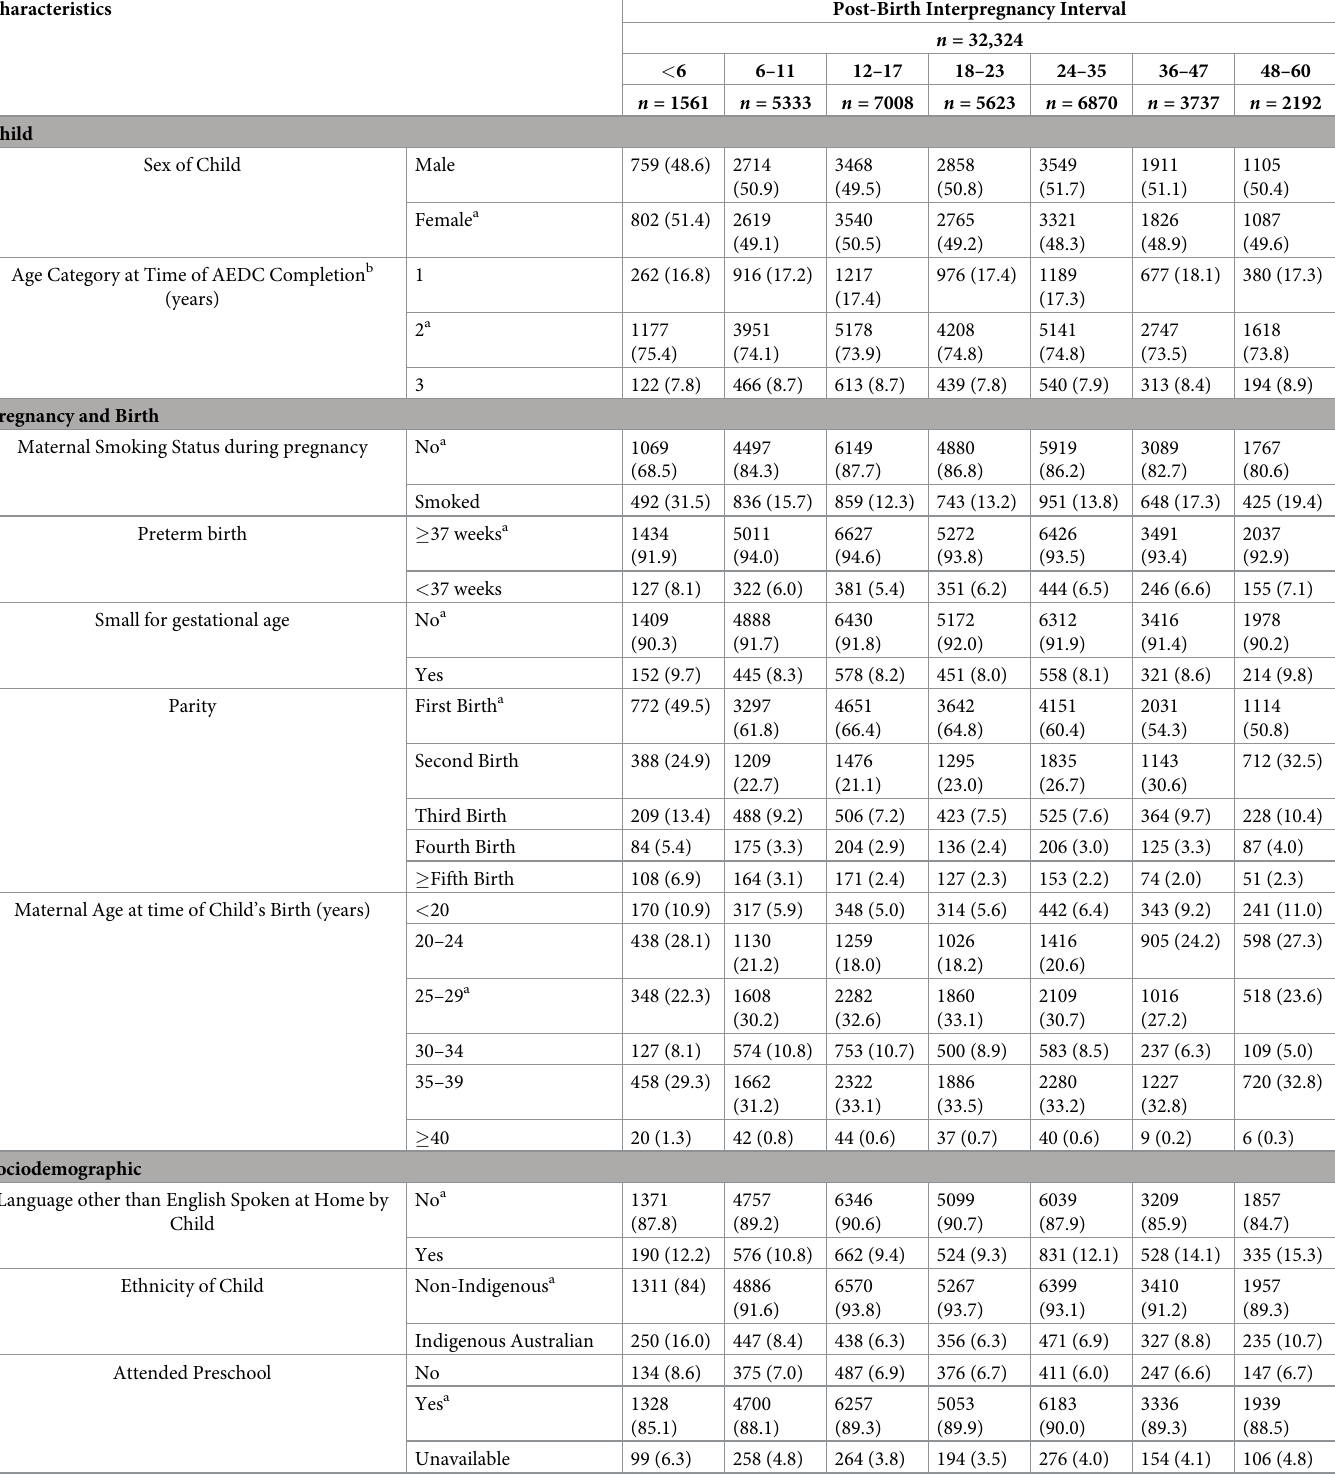
Table 1. Sociodemographic characteristics of the study cohort.